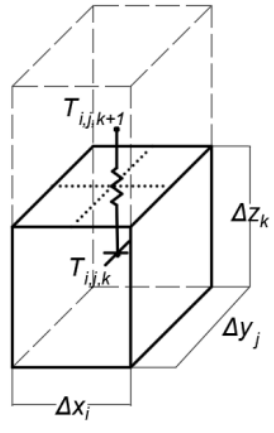
Figure 6. Computational cells ( i ; j ; k ) and ( i ; j ; k +1) [38].